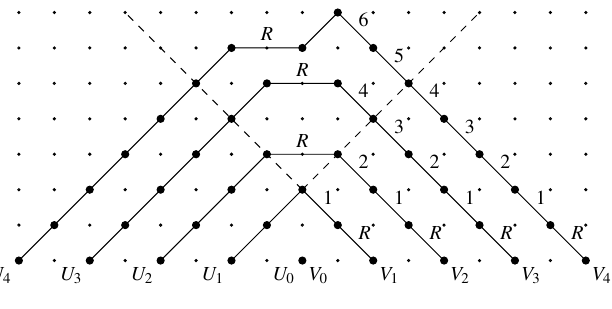
Figure 7: A disjoint collection σ in X ( U 0 ,..., U 4 ; V 0 ,..., V 4 ) with the path weighting W rB marked on. The dashed lines mark the region in which the collection can do something